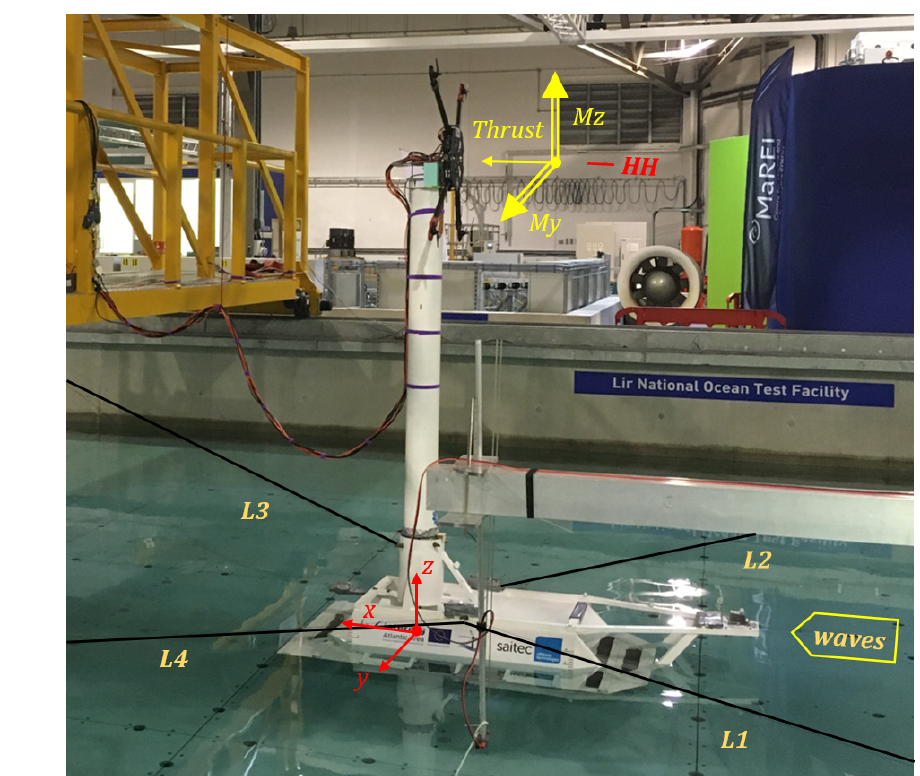
Figure 3. SATH 10MW scaled